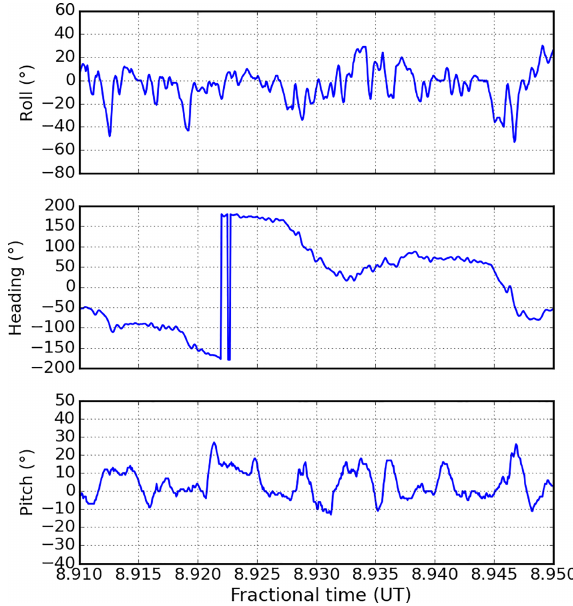
Figure 9. Attitude angles measured by the UAV autopilot during one loop of the first flight on 11 September